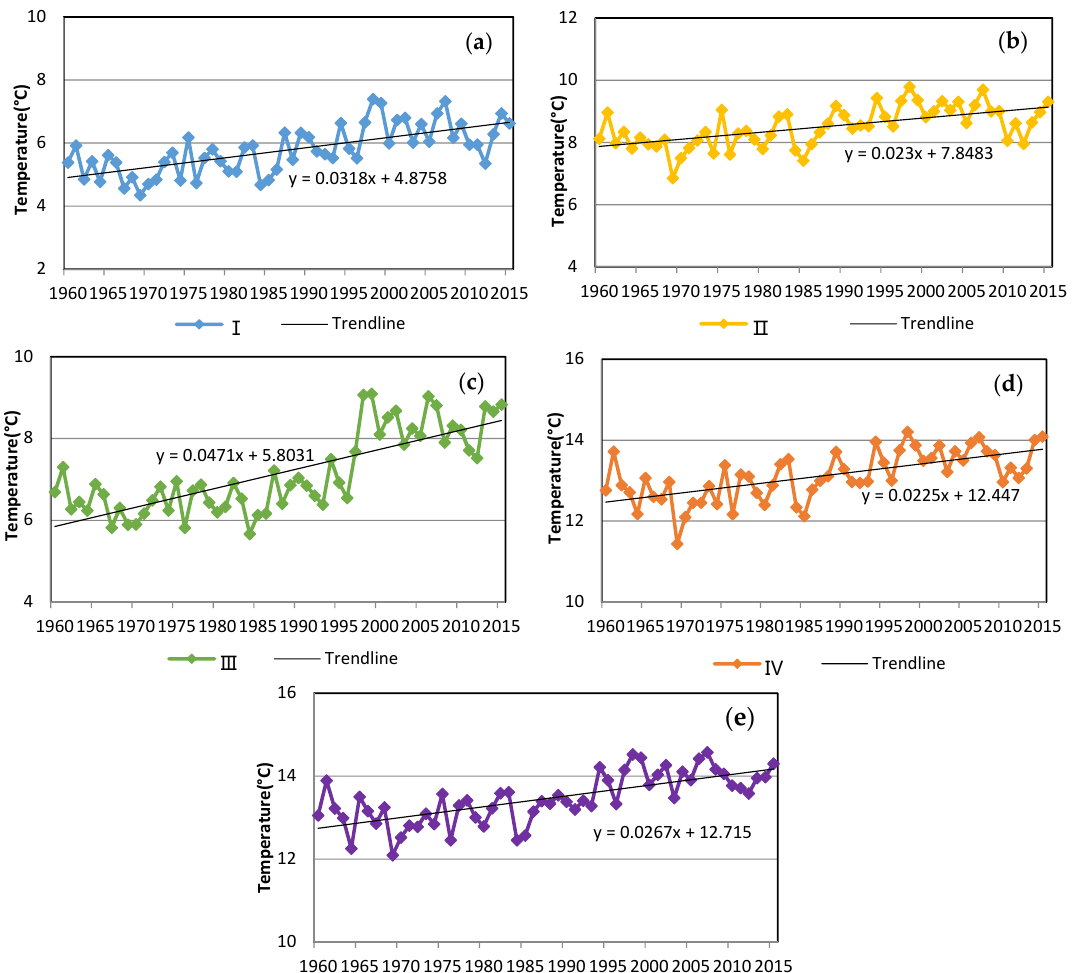
Figure 5. Trend analysis of temperature for the five sub ‐ regions ( a ) region I; ( b ) region II; ( c ) region III; ( d ) region IV; ( e ) region V in the Haihe River Basin (1960–2015).